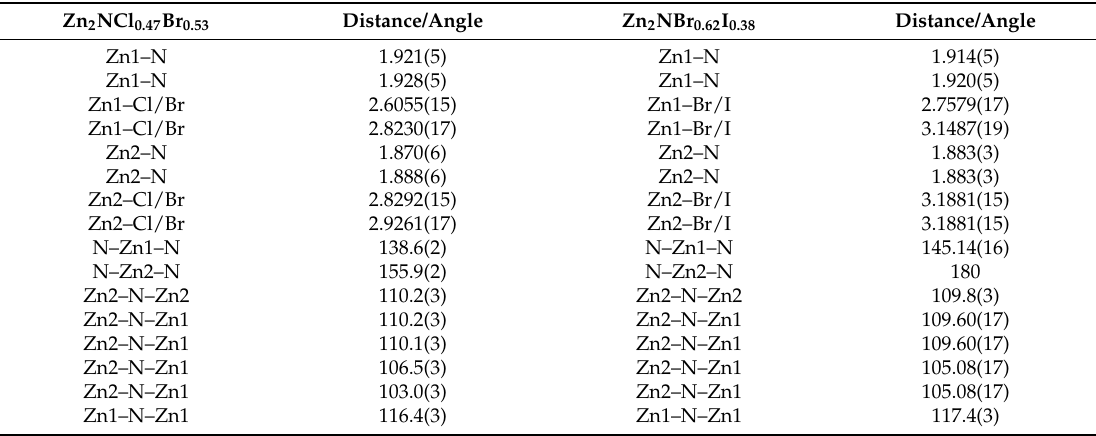
Table 5. Selected bond distances (Å) and angles ( ◦ ) in Zn 2 NCl 0.47 Br 0.53 and Zn 2 NBr 0.62 I 0.38